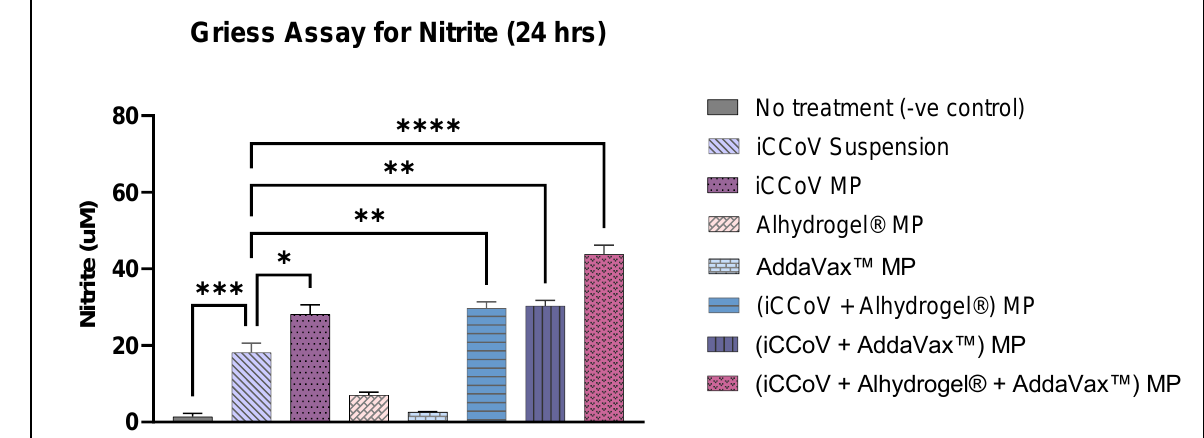
8 of 18 Table 2. Characterization results of vaccine and adjuvant MP.